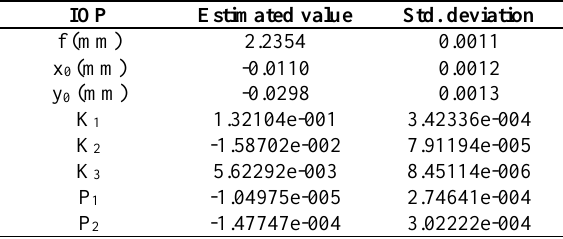
Table 2. Estimated values of IOPs and the standard